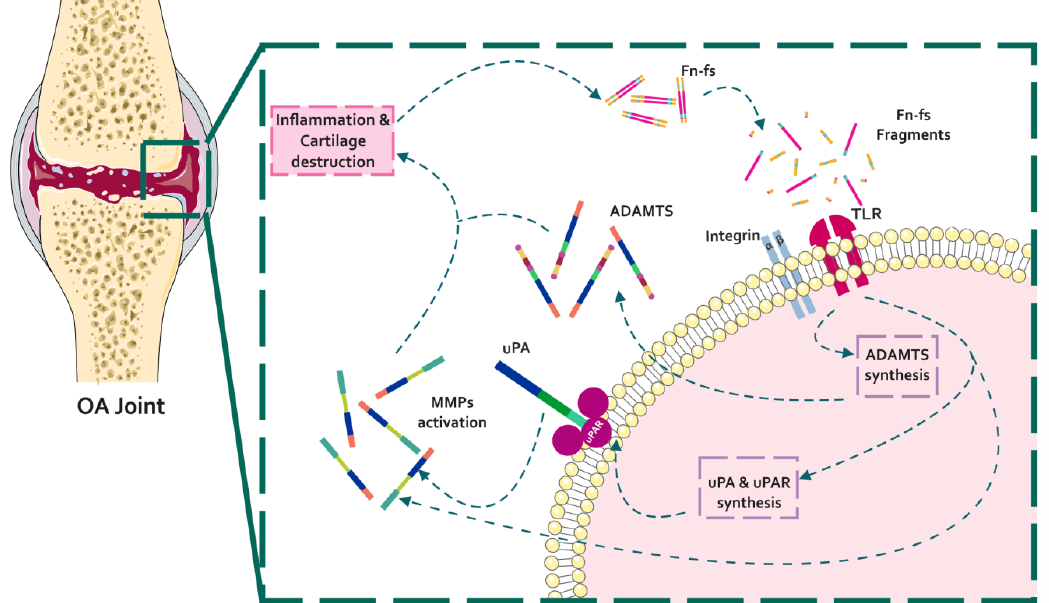
Figure 4. Schematic representation of the interaction of Fn with proteinases in the context of OA pathology. In a situation of inflammation and cartilage damage, Fn cleavage from the cartilage ECM promotes the release of Fn-fs to the joint microenvironment. Binding of Fn-fs to their receptors (integrins and TLRs) activates different signaling pathways increasing the expression of proteinases (uPA, MMPs, and ADAMTSs). In turn, active proteinases degrade the cartilage ECM inducing a feed-back loop of inflammation and cartilage degradation.